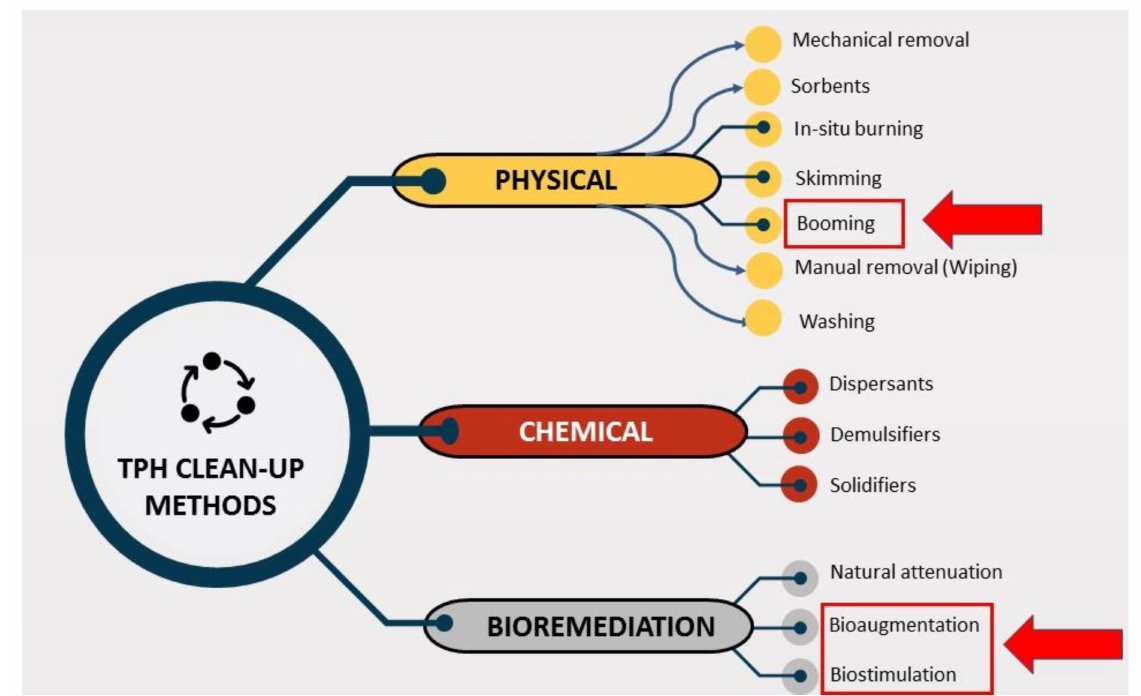
Figure 7. Total petroleum hydrocarbons (TPH) oil spill treatment/clean-up